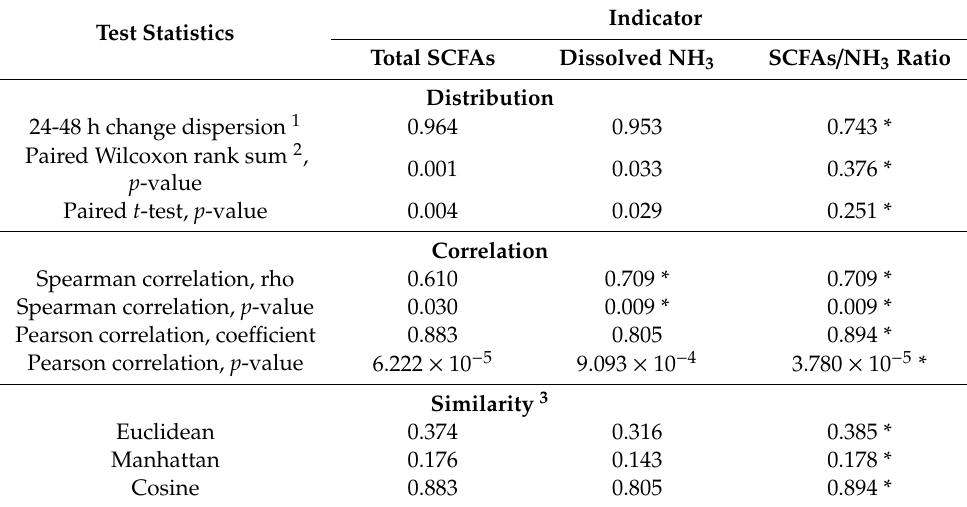
Table 2. Di ff erent test statistics of total short-chain fatty acids, dissolved ammonia, and the SCFAs / NH 3 ratio at 24 and 48 h. Robustness of indicator could capture most of the essential information at both 24 and 48 h to allow a rough but valid comparison between the two time-points in